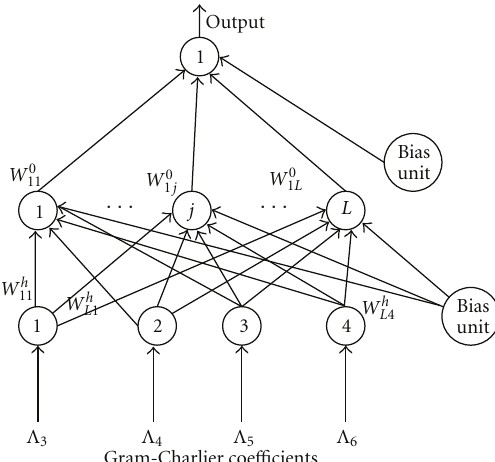
Figure 7: Back propagation neural network. If output ≥ 0, then input type of biocrystallogram sample image belongs to process class (pureed) or it belongs to fresh class (where L is 19).